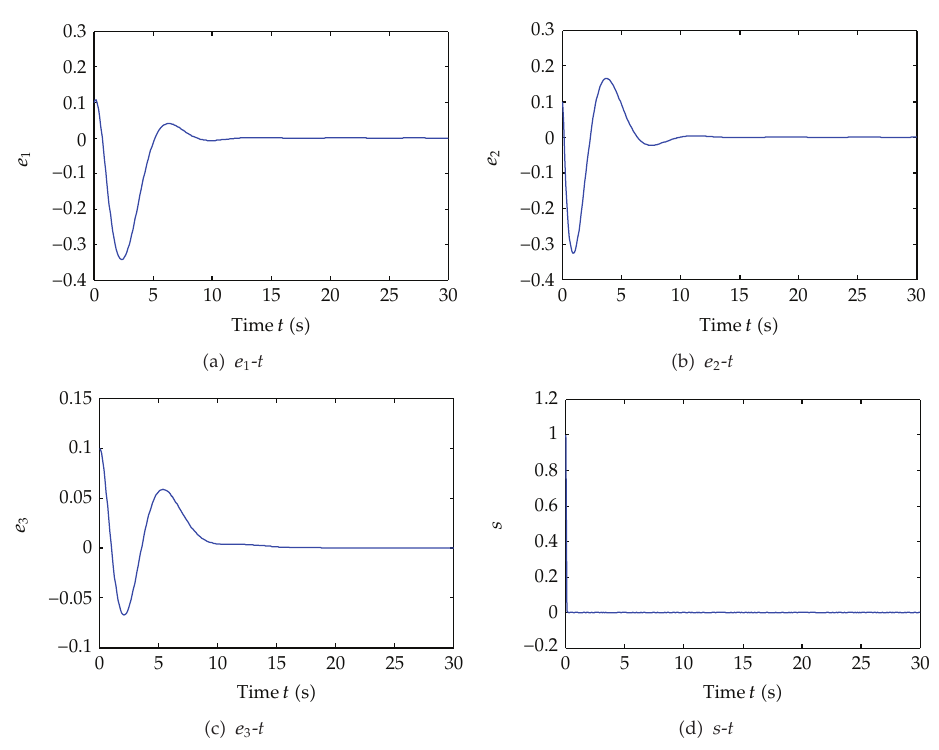
Figure 6: The time response of the error system and sliding mode